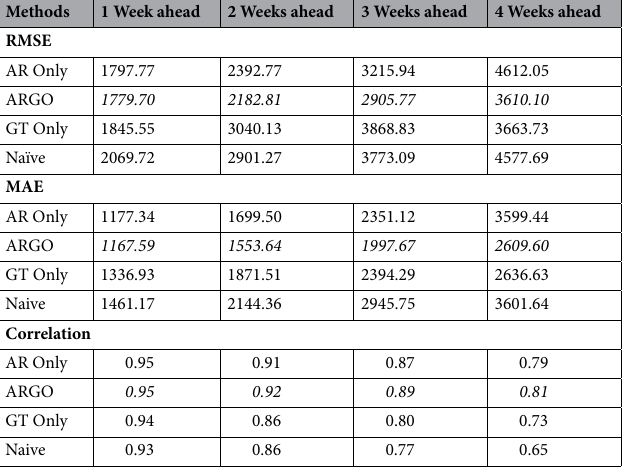
Table 1. National level 1 to 4 weeks ahead COVID-19 incremental prediction comparisons in 3 error metrics. The best performances for each metric in each study period are italicized. All comparisons are based on the original scale of COVID-19 national incremental death. On average, ARGO is able to achieve around 22% RMSE, 27% MAE reduction, and 9% correlation improvement, compared to the Naïve predictions.